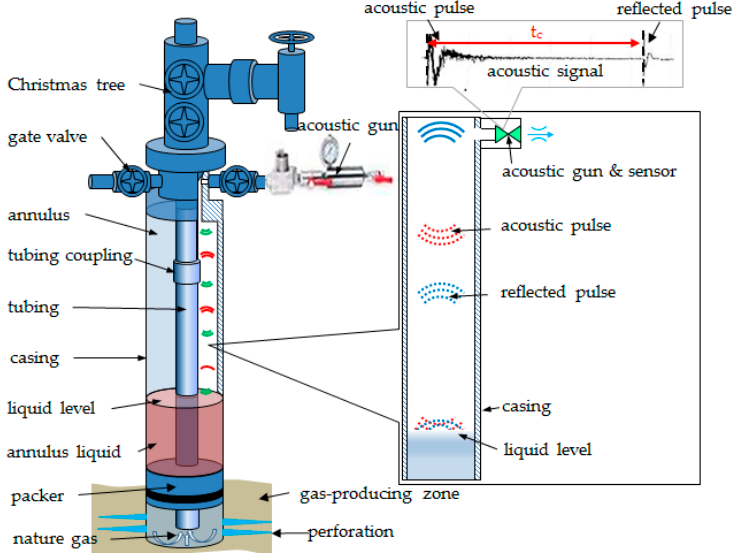
Figure 1. Schematic diagram of acoustic level measurement.